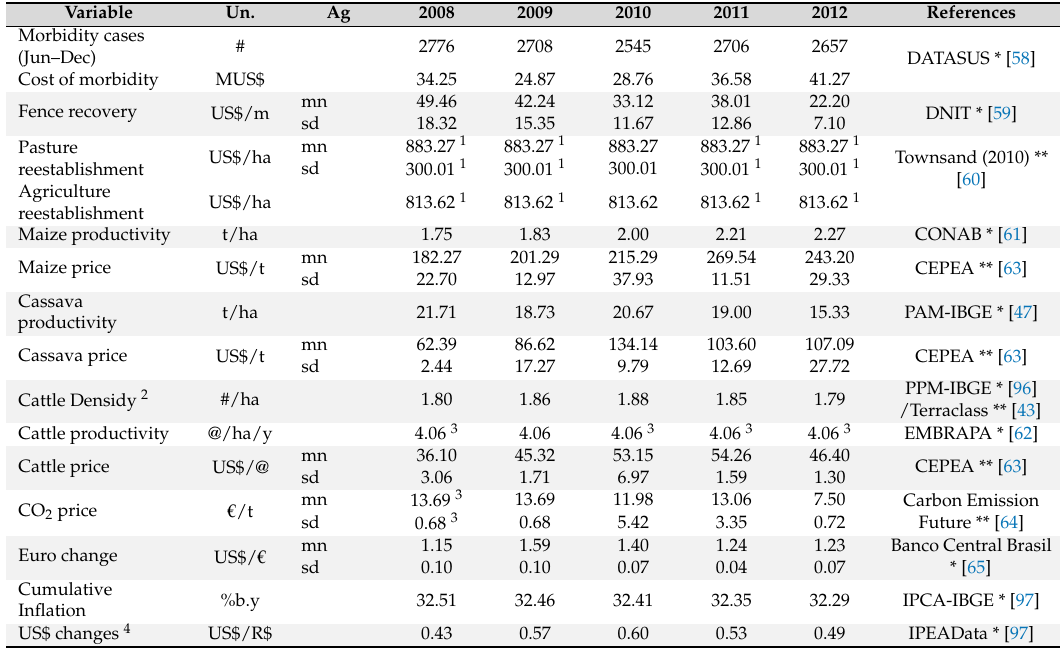
Table A2. Costs, prices, and index